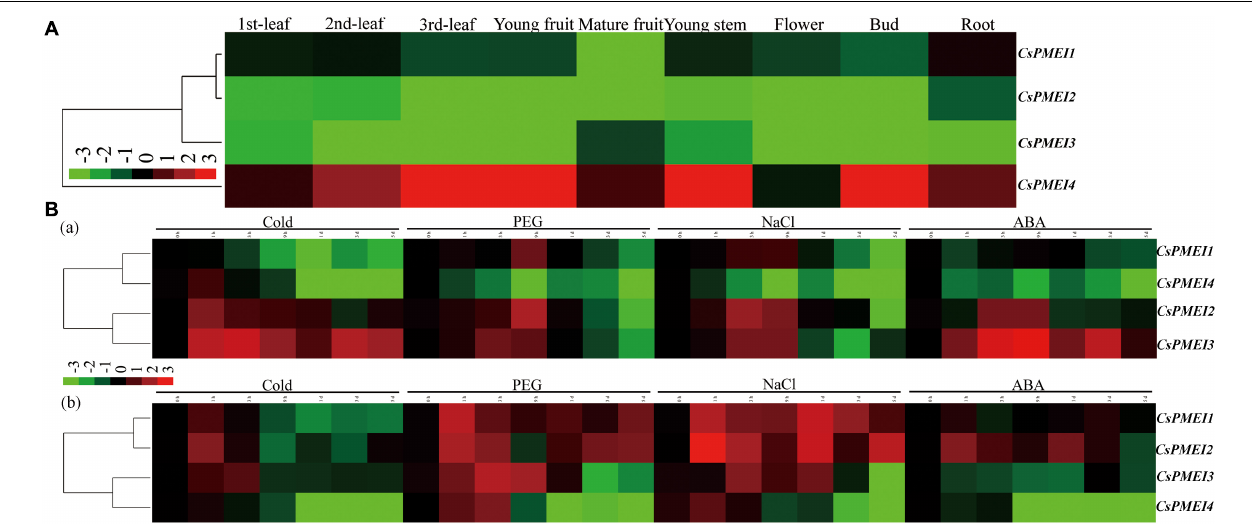
FIGURE 2 | Expression profiles of CsPMEIs in tea plant. (A) Tissue-specifc expression patterns of CsPMEIs in different tea plant tissues. The relative expression levels were calculated by using 2 - (cid:49) Ct method. The colorbar was displayed on the lower-left of the heat map, red and green colors represent higher and lower expression levels, respectively. (B) Temporal-spatial expression patterns of CsPMEIs both in tea plant mature leaves and roots under various abiotic stresses. (a) The expression patterns of CsPMEIs in mature leaves; (b) The expression patterns of CsPMEIs in roots. Samples at 0 h were used as control, and the final results were calculated with 2 - (cid:49) (cid:49) Ct method. The colorbar was presented on the left side of the heat map, red and green colors represent higher and lower expression levels, respectively. Data are shown as the means ± SE ( n =